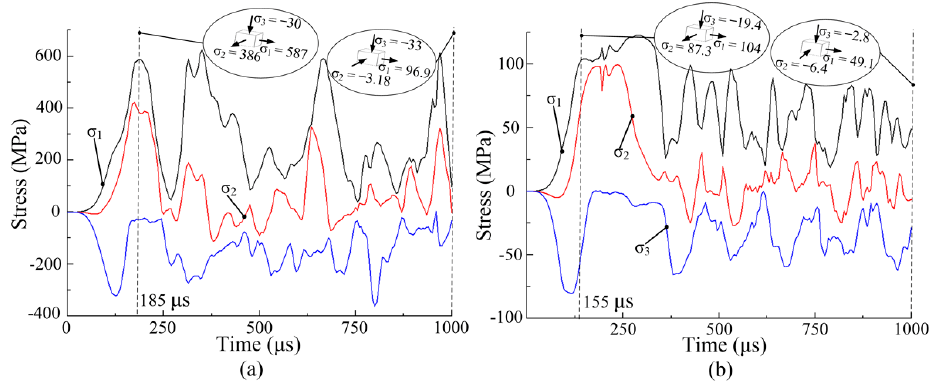
Figure 14. Variation of three principal stresses with time at node B: ( a ) 200°C; ( b ) 400°C.